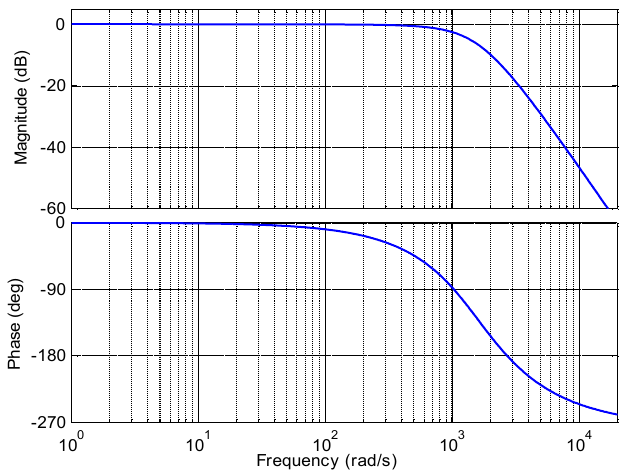
Figure 14. Closed ‐ loop characteristic curve of the nominal plant. Figure 14. Closed-loop characteristic curve of the nominal